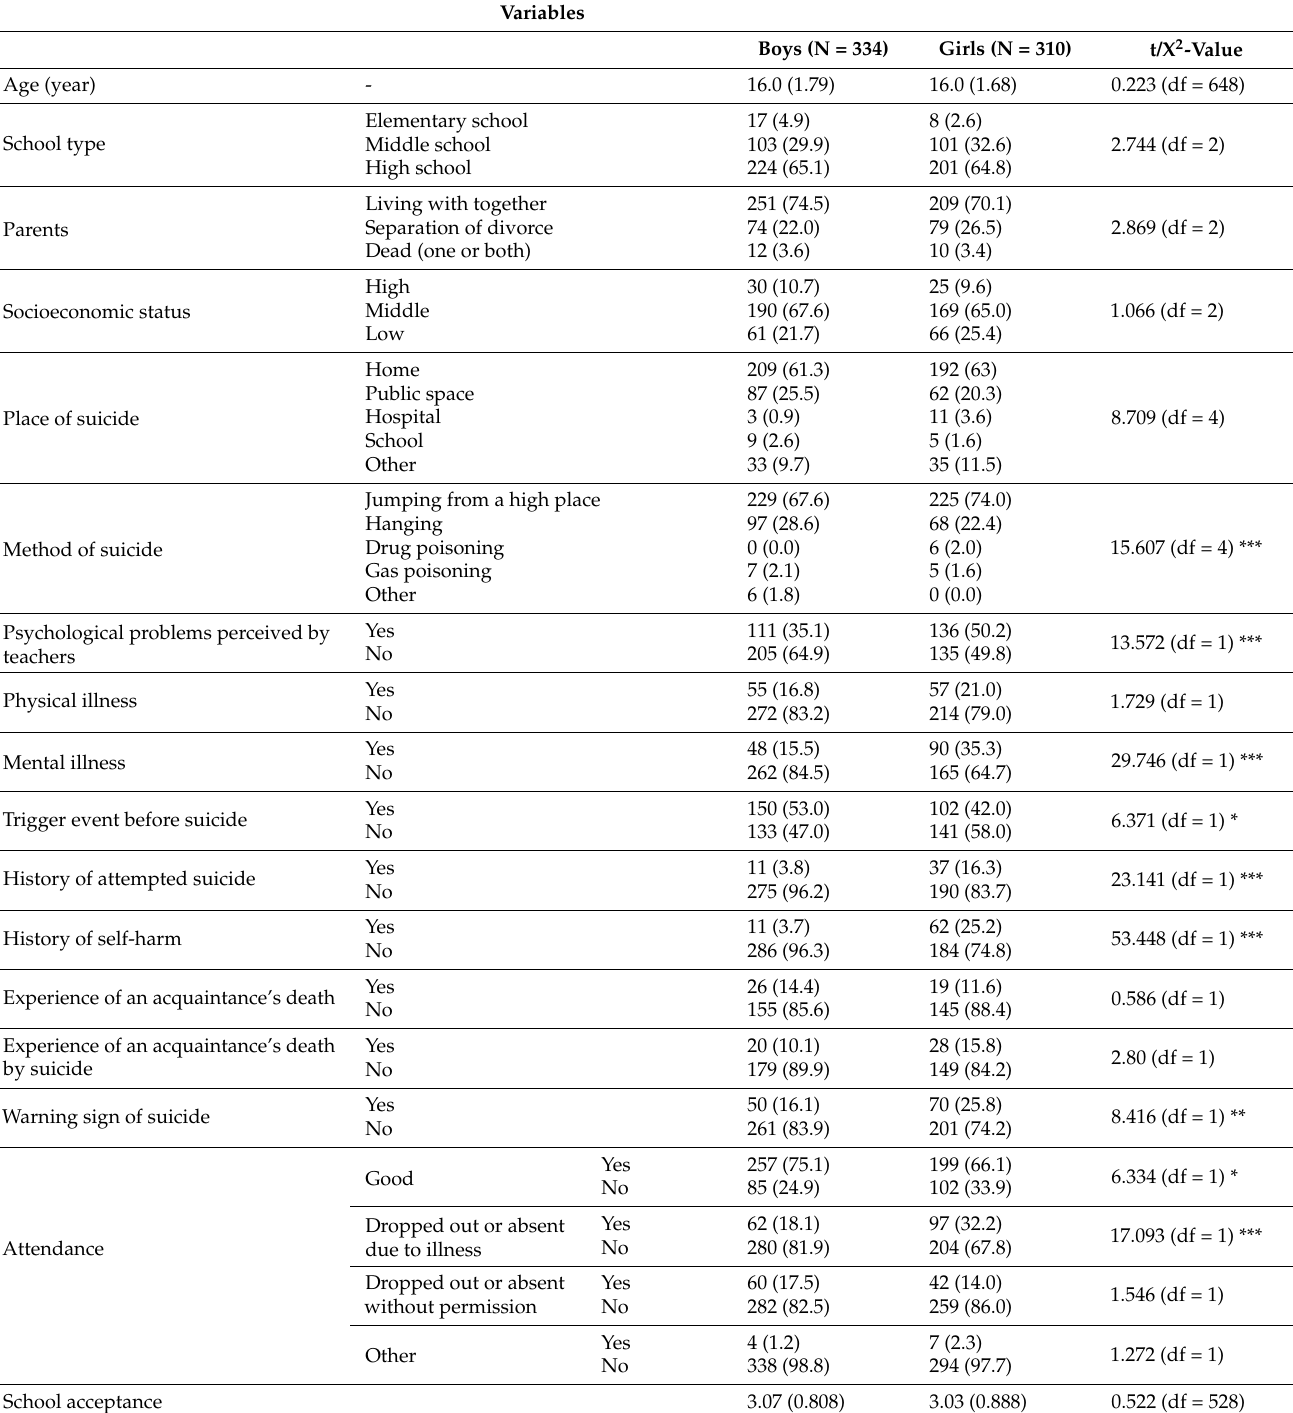
Table 3. Comparison of gender differences of students who died by suicide in 2016–2020 (N = 654).